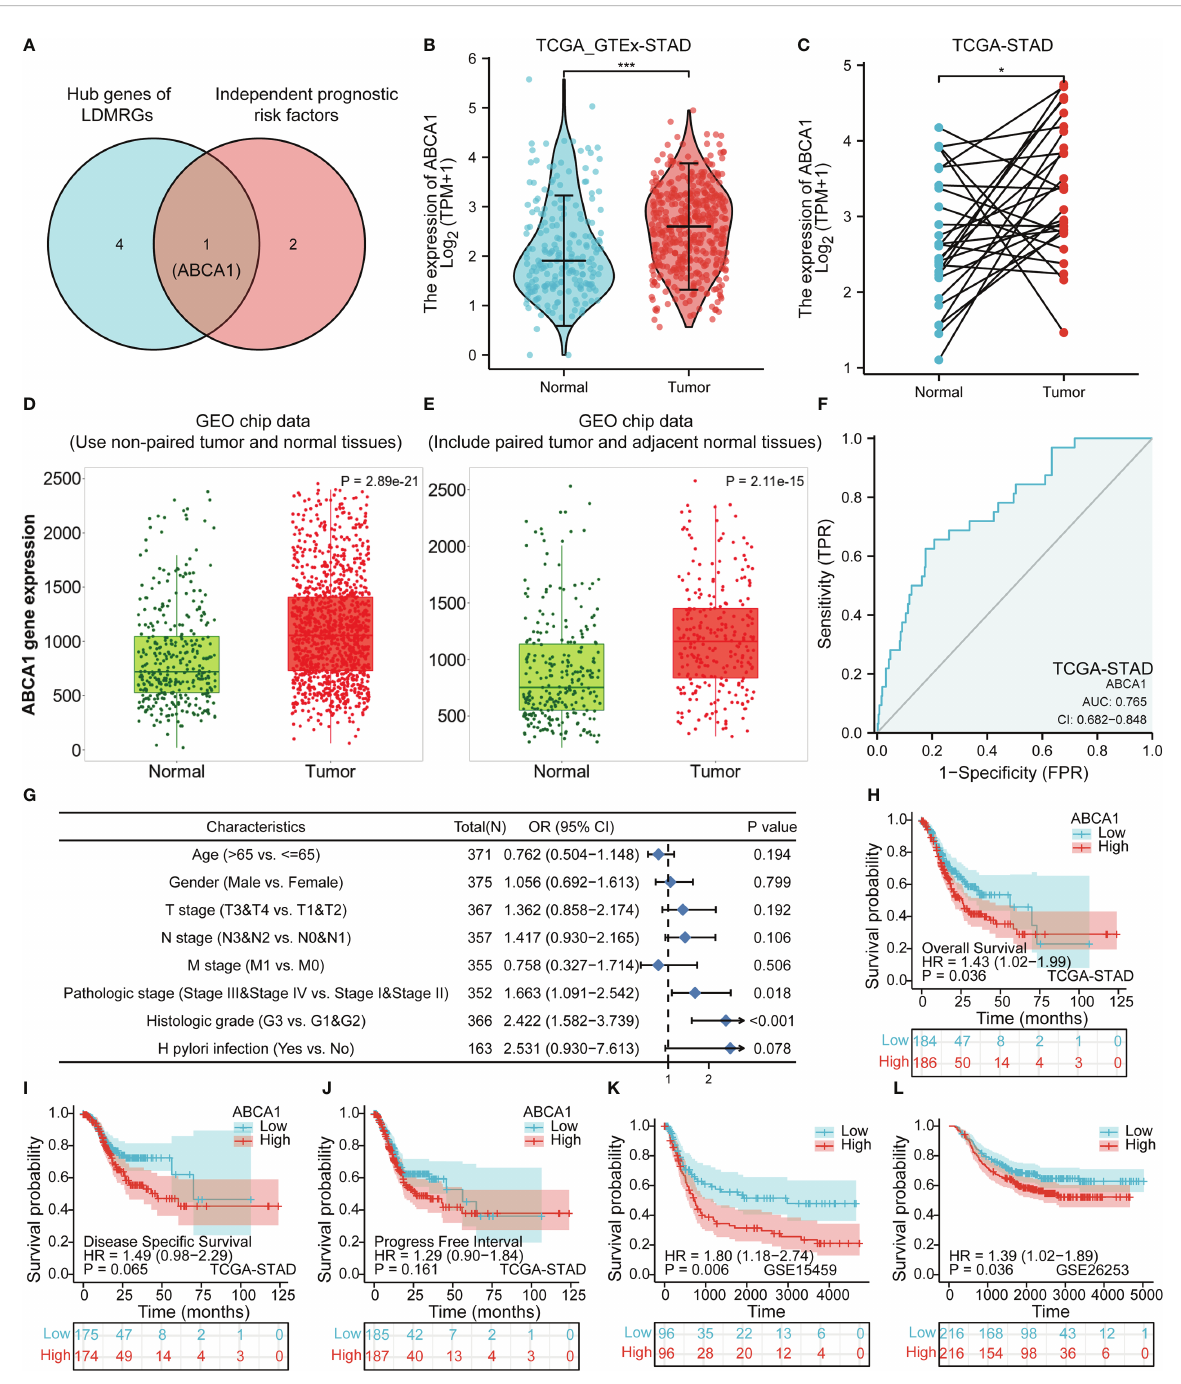
FIGURE 8 Expression and prognostic analysis of ABCA1 in gastric cancer. (A) Identi fi cation of the key gene, ABCA1, in LDMRGs in STAD. (B – E) Differential expression analysis of ABCA1 in gastric cancer using TCGA and GEO databases. (F) The diagnostic value of ABCA1 expression in gastric cancer was analyzed by ROC curve in STAD. (G) The correlation between ABCA1 expression and clinical characteristics was analyzed by logistic regression in STAD. (H – J) Correlation analysis of ABCA1 expression and survival prognosis in the TCGA-STAD cohort, including OS, DSS, and PFI. (K, L) Correlation analysis of ABCA1 expression and OS prognosis in the GSE15459 and GSE26253 cohorts. (*: p ≤ 0.05, ***: p ≤